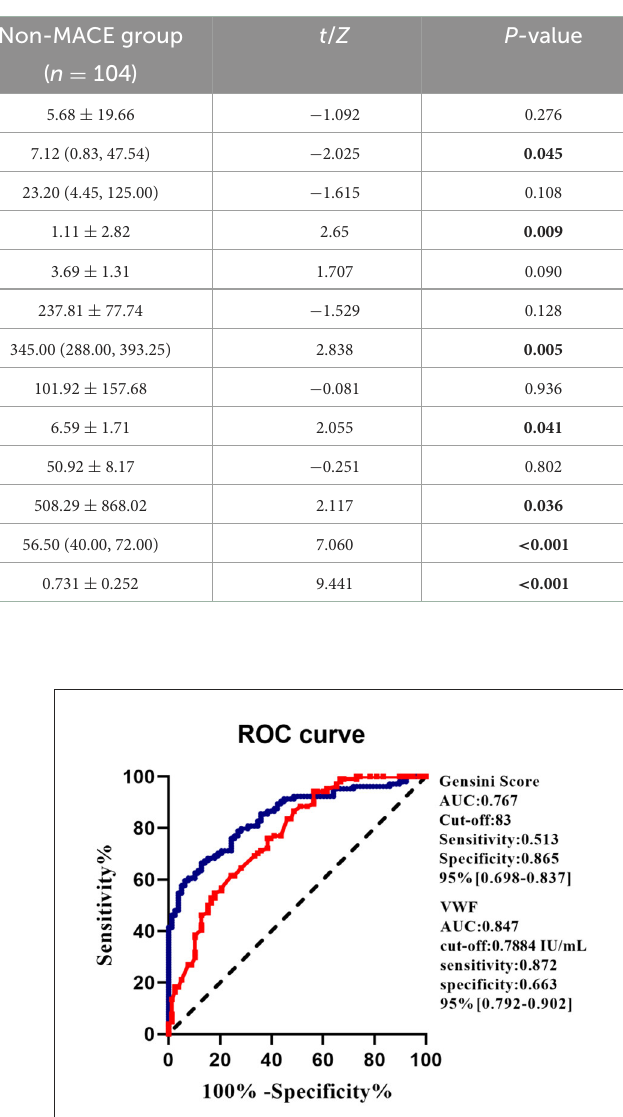
FIGURE3 ROC curves of the VWF: Ag level and Gensini score for MACE prediction after 2 years of follow-up in patients with AMI. AUC, area under the curve; CI, confidence